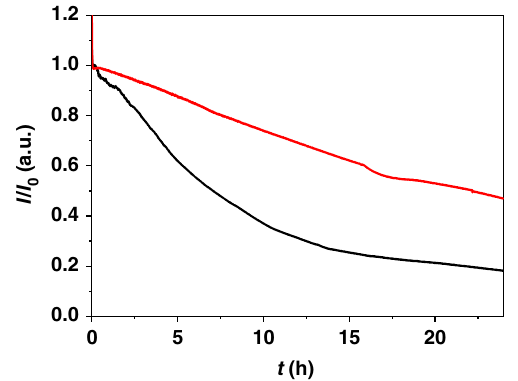
Fig. 5 Long-term stability of the biofuel cell. Current output of the hydrogen/air-breathing biofuel cell comprising a P(GMA-BA-PEGMA)- vio//P(N 3 MA-BA-GMA)-vio/ Dv MF-[NiFe] bioanode (black trace) or a P (GMA-BA-PEGMA)-vio//P(N 3 MA-BA-GMA)-vio/ Dv MF-[NiFe] bioanode covered with a stabilizing P(SS-GMA-BA) layer (red trace) at a constant cell voltage of 0.7 V in 0.1 M phosphate buffer (pH 7.4) and the air- breathing Mv -BOx biocathode. Nominal hydrogenase loading: 4